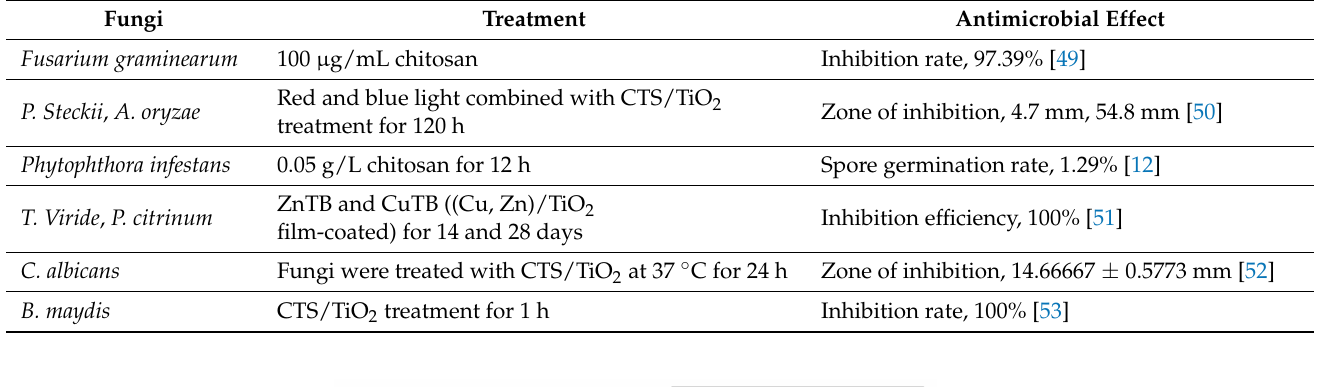
Table 1. Research on antimicrobial activity of chitosan or TiO 2 .